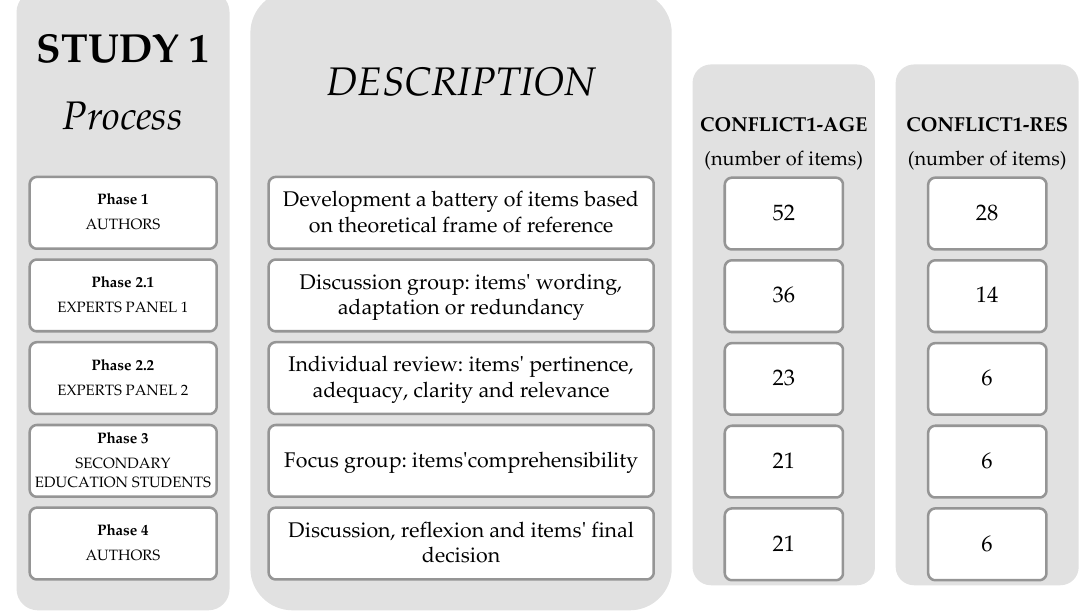
Figure 1. Study 1 process description.